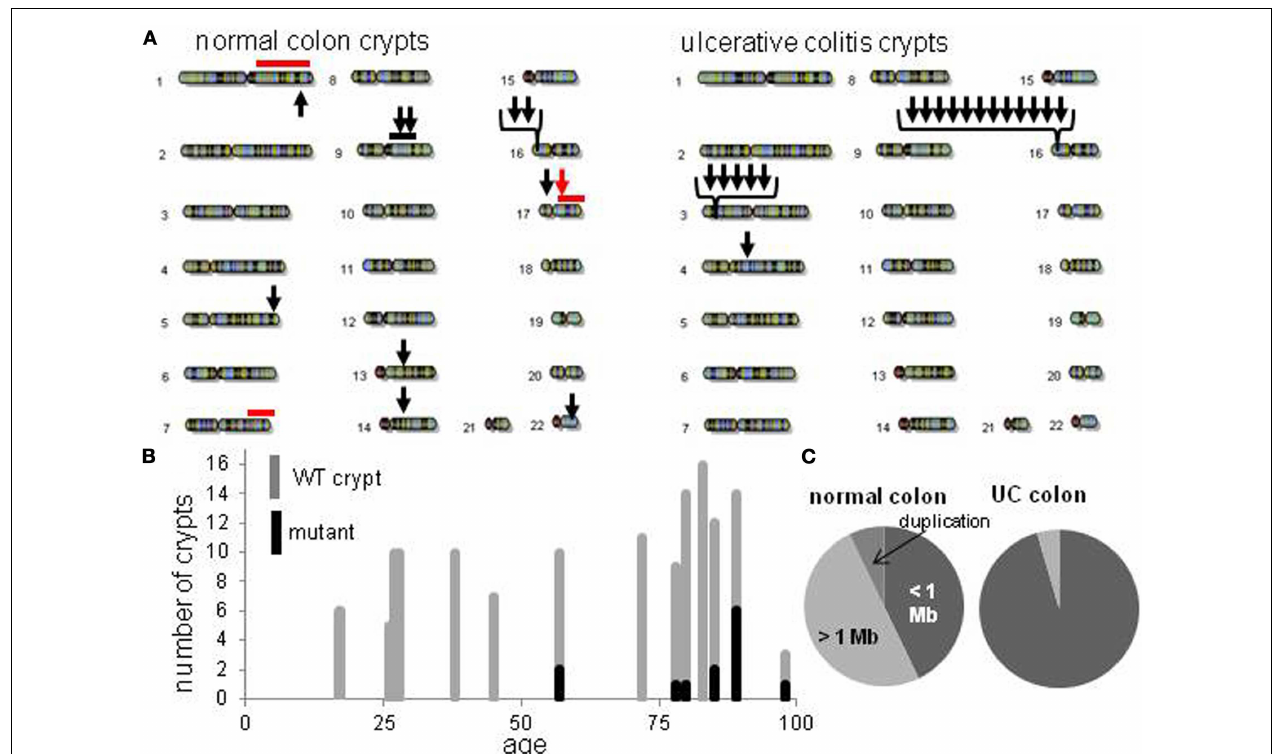
a duplication. (B) Increase in mutant non-UC crypts with age. (C) Relative proportions of chromosome CNA types in normal colon crypts and normal UC